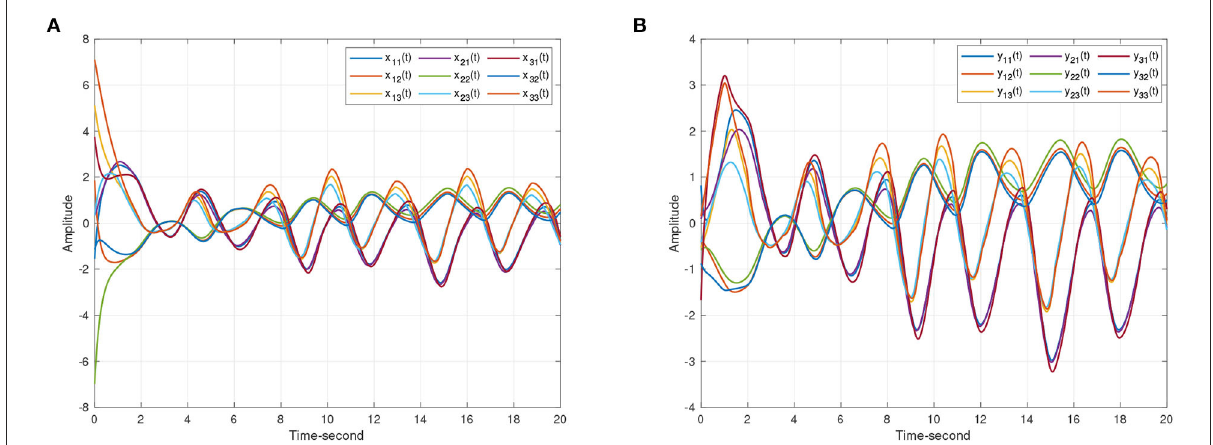
FIGURE4 The state trajectories produced by systems (8) and (9) without the controller. (A) The state curves of drive system (8). (B) The state curves of response system